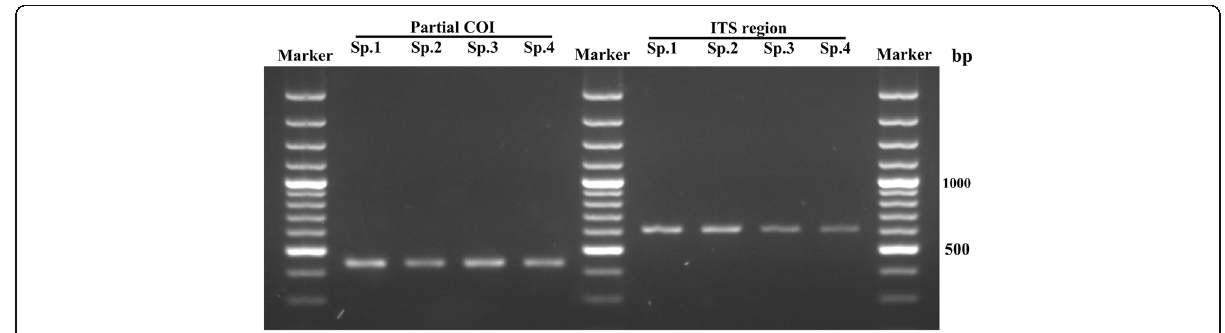
Fig. 1 PCR products of partial COI gene and ITS genes in four indigenous isolates of B. bassiana from Taif,